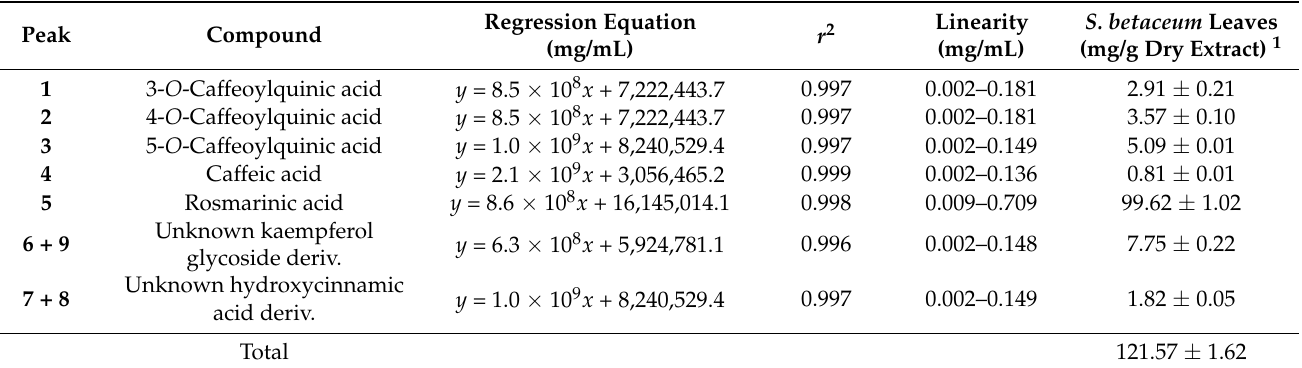
Table 1. Phenolic compound contents of S. betaceum aqueous extract. Regression equation, r 2 values and linearity of the reference compounds with the employed analytical conditions.